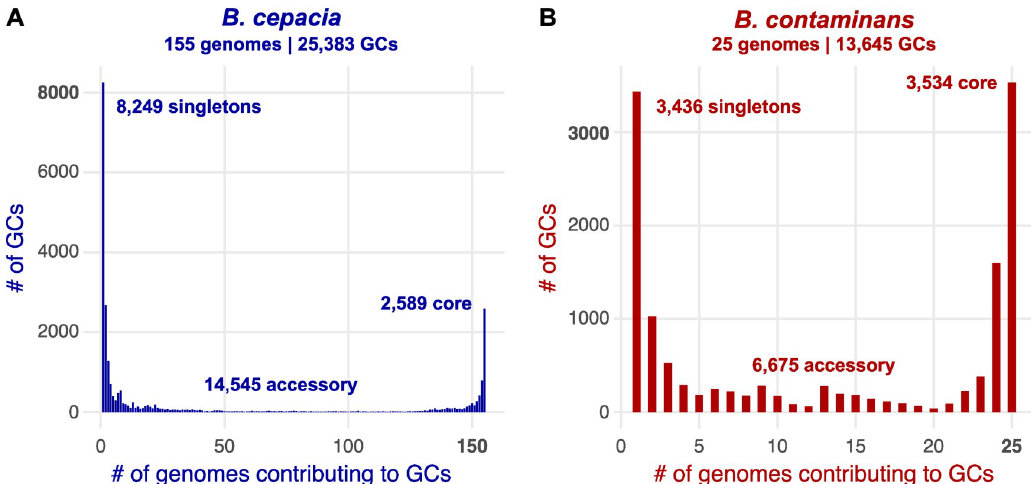
Fig 2. Gene-cluster distributions for (A) B . cepacia and (B) B . contaminans .